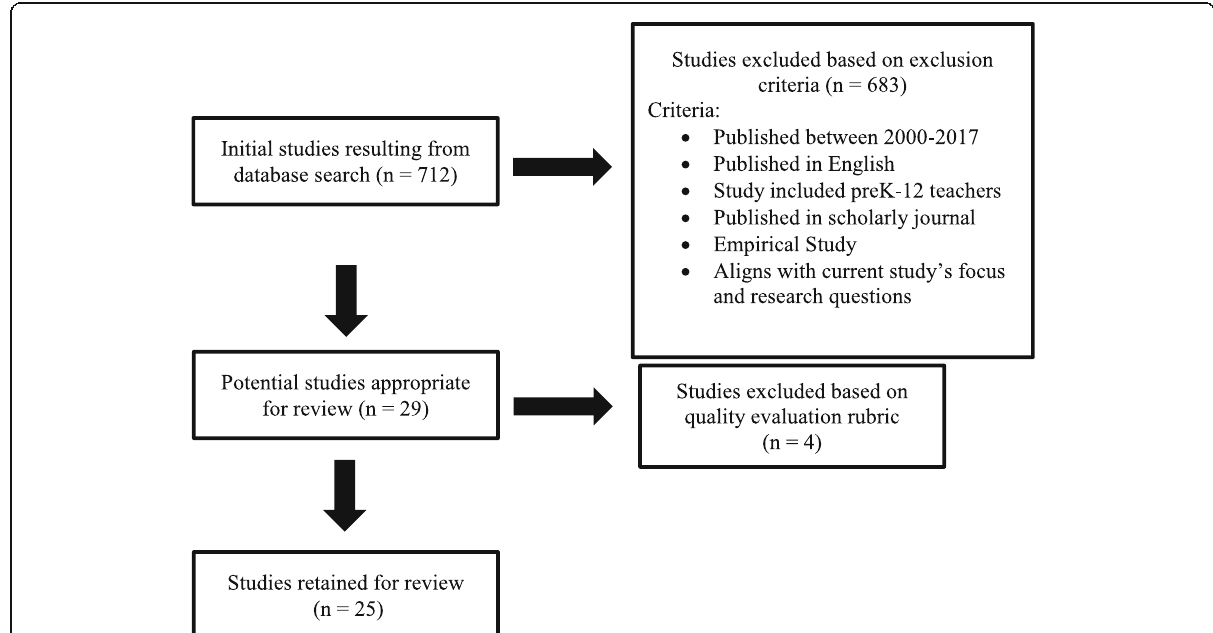
Fig. 1 Diagram of the screening process. The diagram shows how the studies were culled down from the initial database search to the final retained